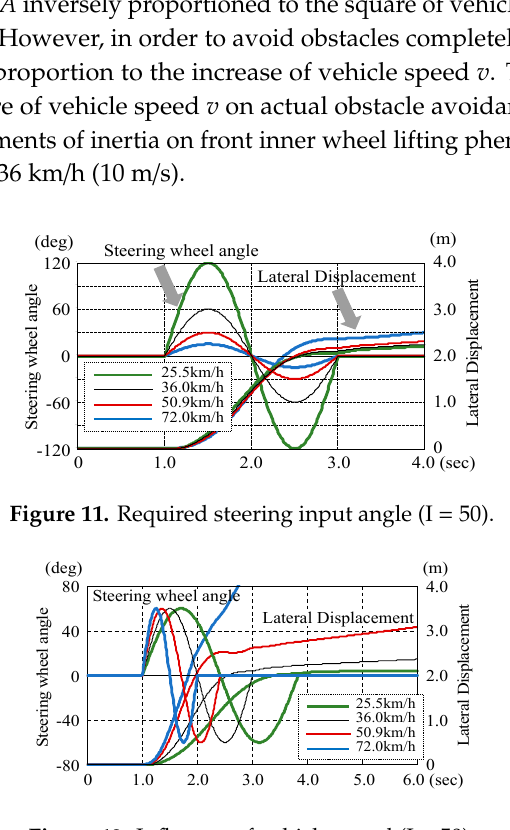
Figure 12. Influence of vehicle speed (I = 50).